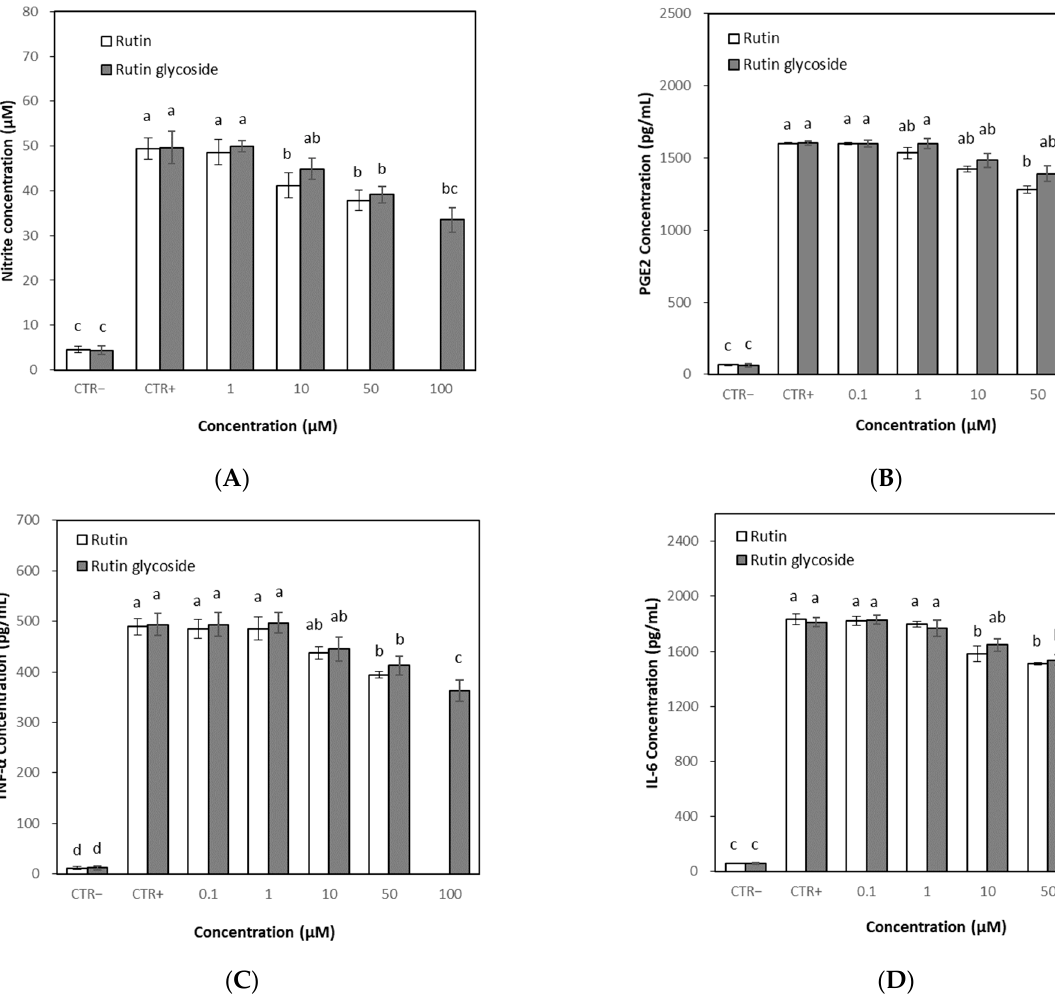
Figure 6. Effect of rutin and rutin glycoside on the production of nitric oxide (NO), Prostaglandin E (PGE) 2, tumor necrosis factor (TNF)- α and interleukin (IL)-6. RAW 264.7 cells were cultured with different rutin and rutin glycoside concentrations for 24 h with LPS (1 μ g/mL). CTR − , Negative control. CTR+, Positive control (LPS). Results were represented as mean ± SD ( n = 3). ( A ) Effect on NO; ( B ) Effect on PGE2; ( C ) Effect on TNF- α ; ( D ) Effect on IL-6. Different letters (a, b, c, d) above the bars indicate significant differences ( p < 0.05), where ab or bc represents the intermediate significance value between a and b or b and c, respectively.